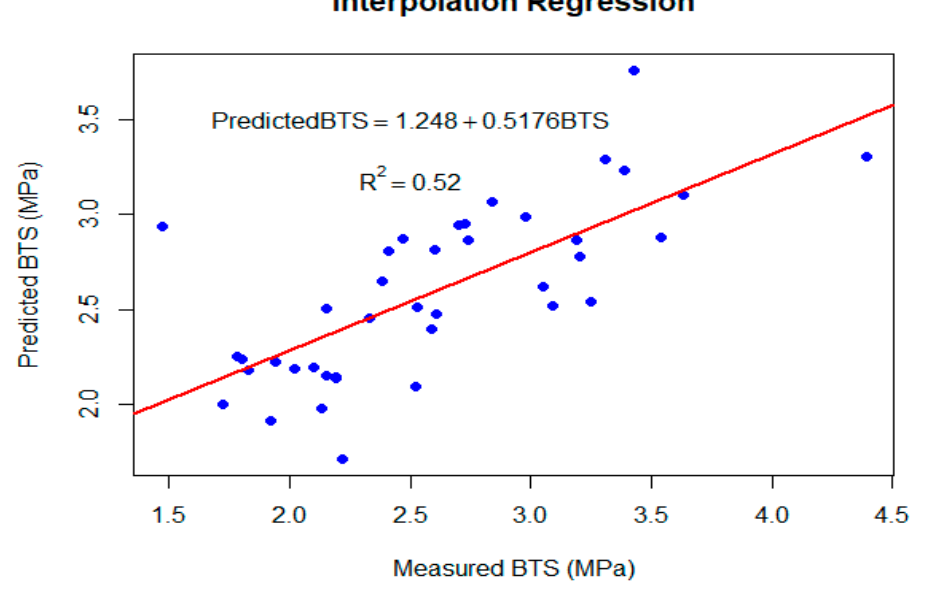
Figure 5. BTS values predicted from interpolation.